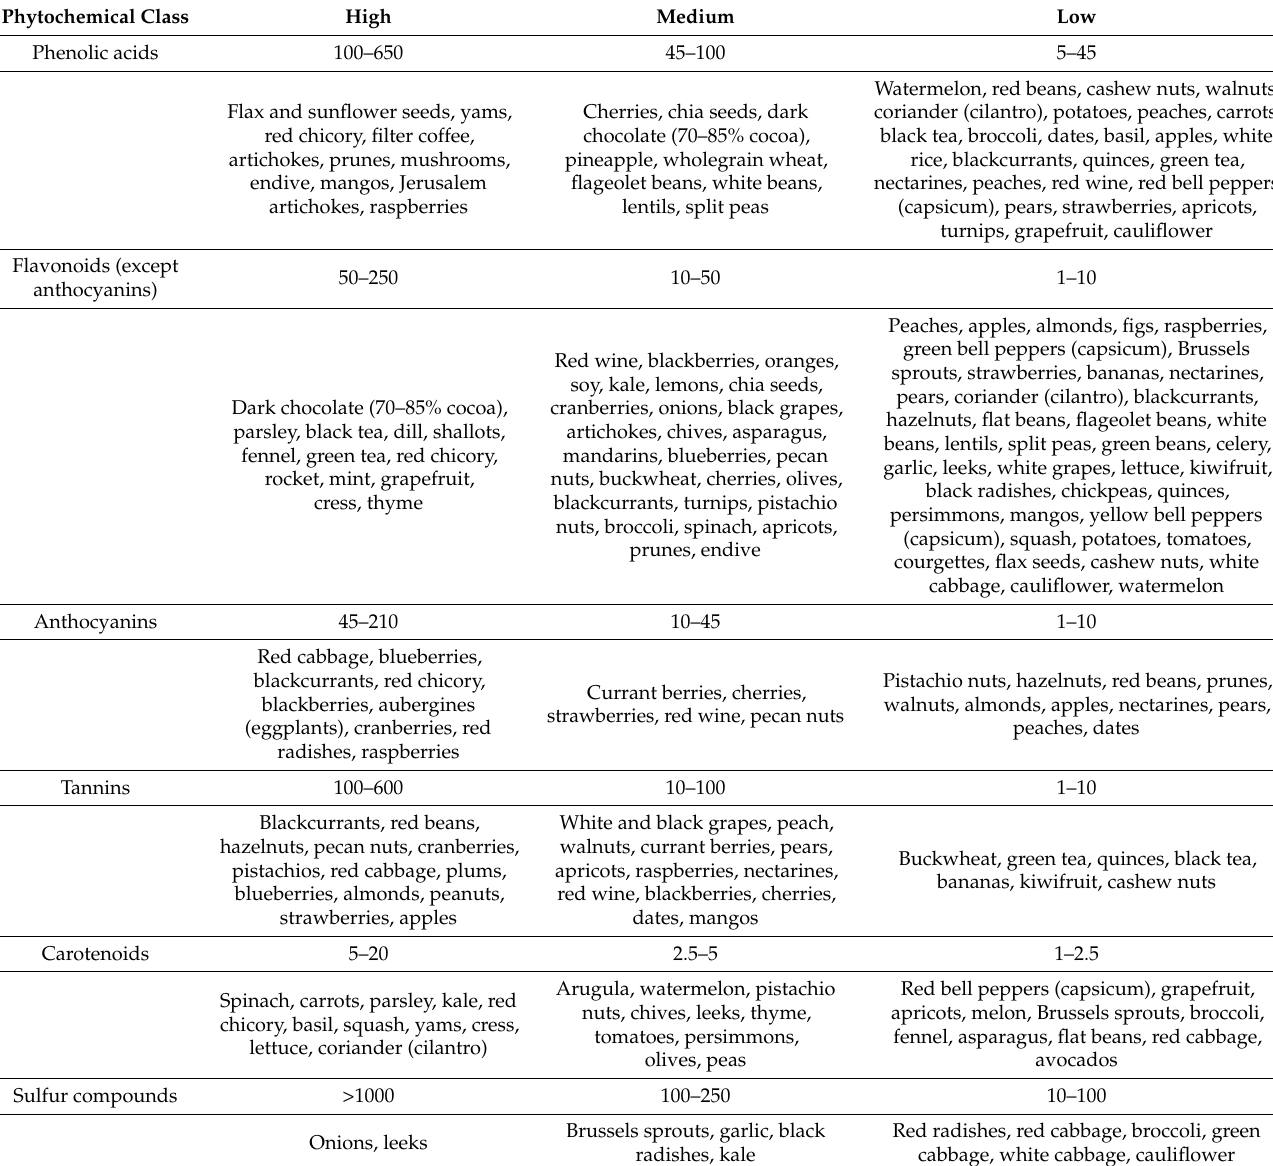
Table 1. Foods and drinks considered to have high, medium, and low levels of different families of phytochemicals [11]. Reference ranges describing high, medium, and low phytochemical levels differ between phytochemical families, and are therefore shown alongside each family above the list of foods. The units of measurement for these reference ranges are mg per 100 g (for foods) or mg per 100 mL (for